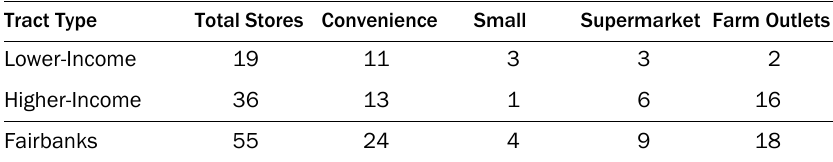
Table 2. Number of Stores and Store Types by Census Tract